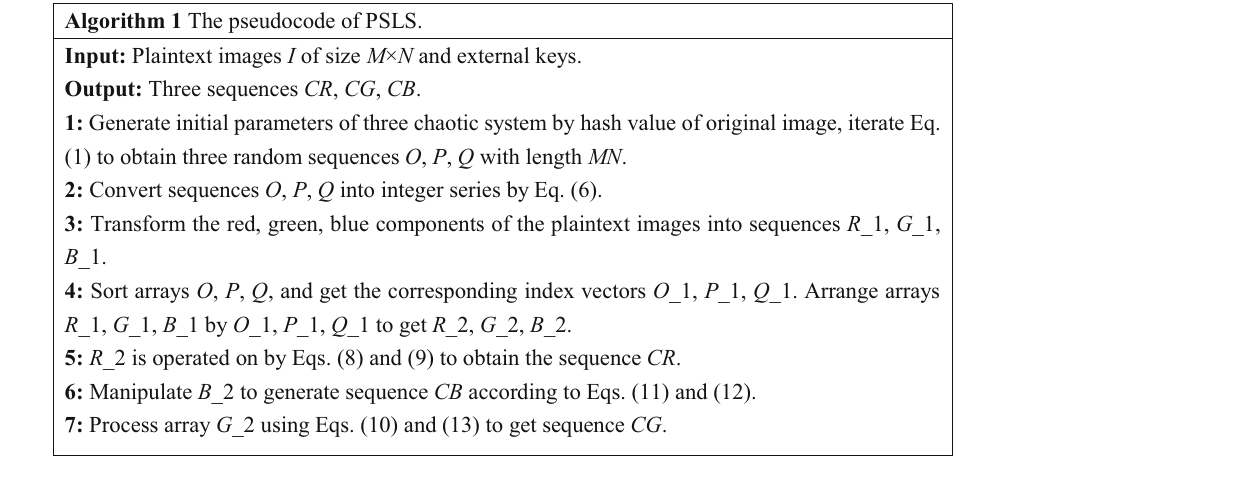
Algorithm 1 The pseudocode of